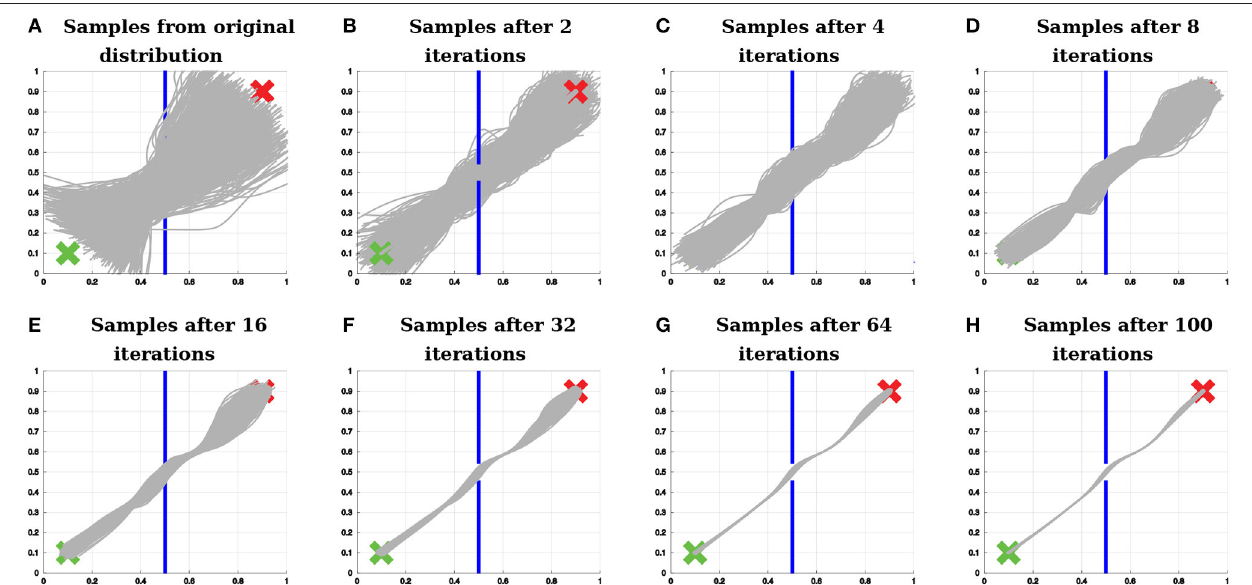
FIGURE 7 | Example of policy search with relevance weighting. The proposed algorithm finds a distribution over trajectories that start and end at the correct positions (represented by the green x and by the red x, respectively) and do not hit the wall (represented by the blue lines).